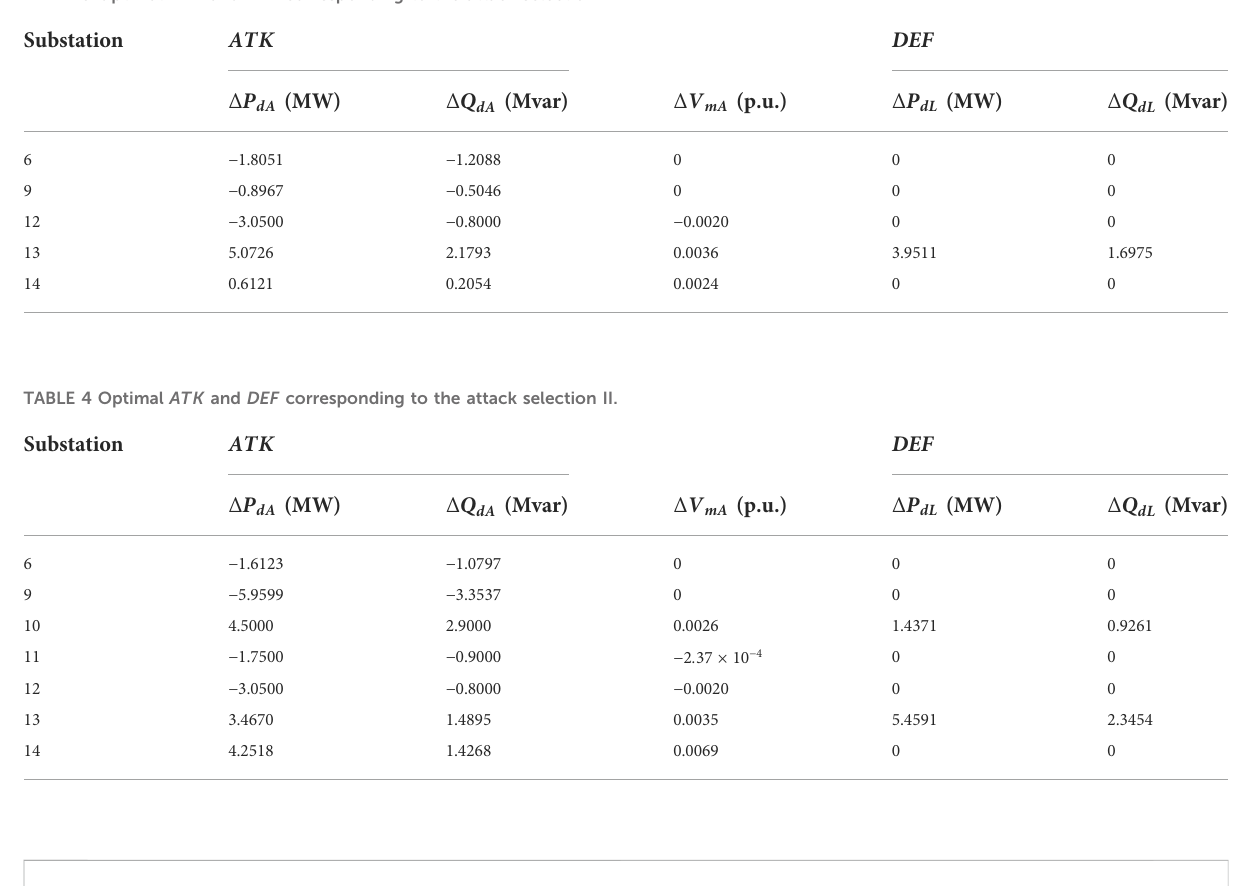
TABLE 3 Optimal ATK and DEF corresponding to the attack selection I.